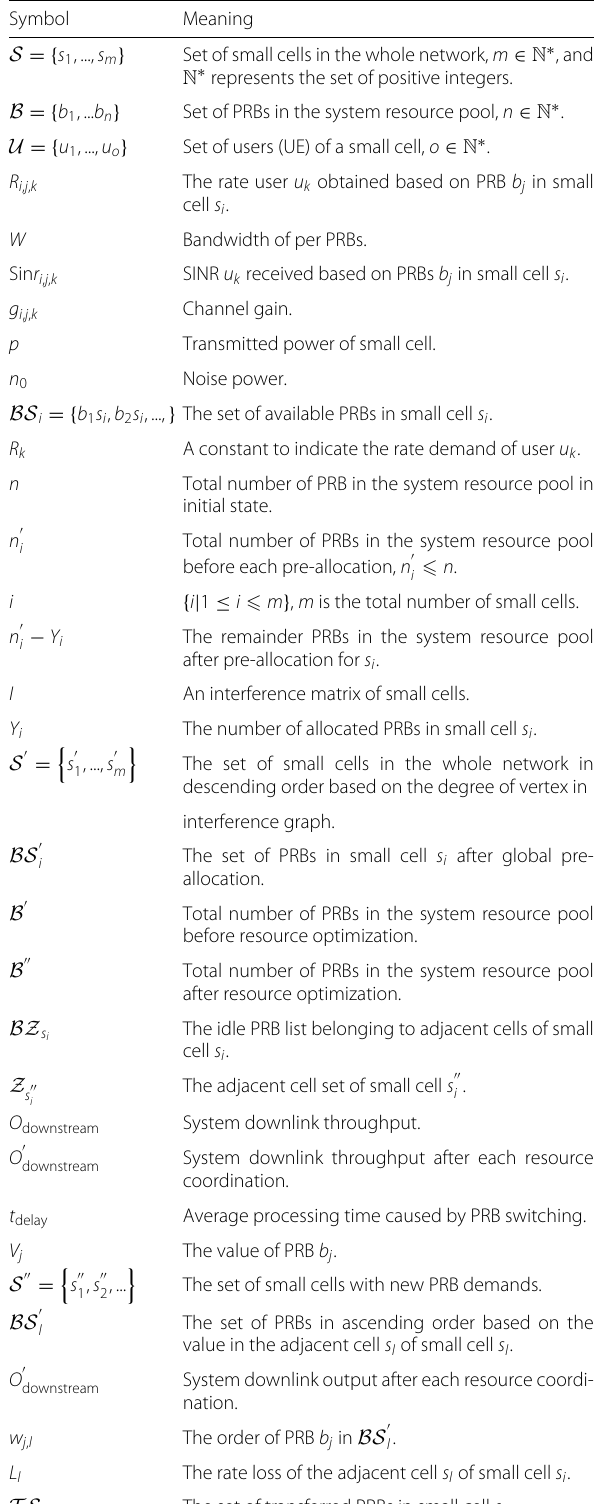
Table 2 Table of